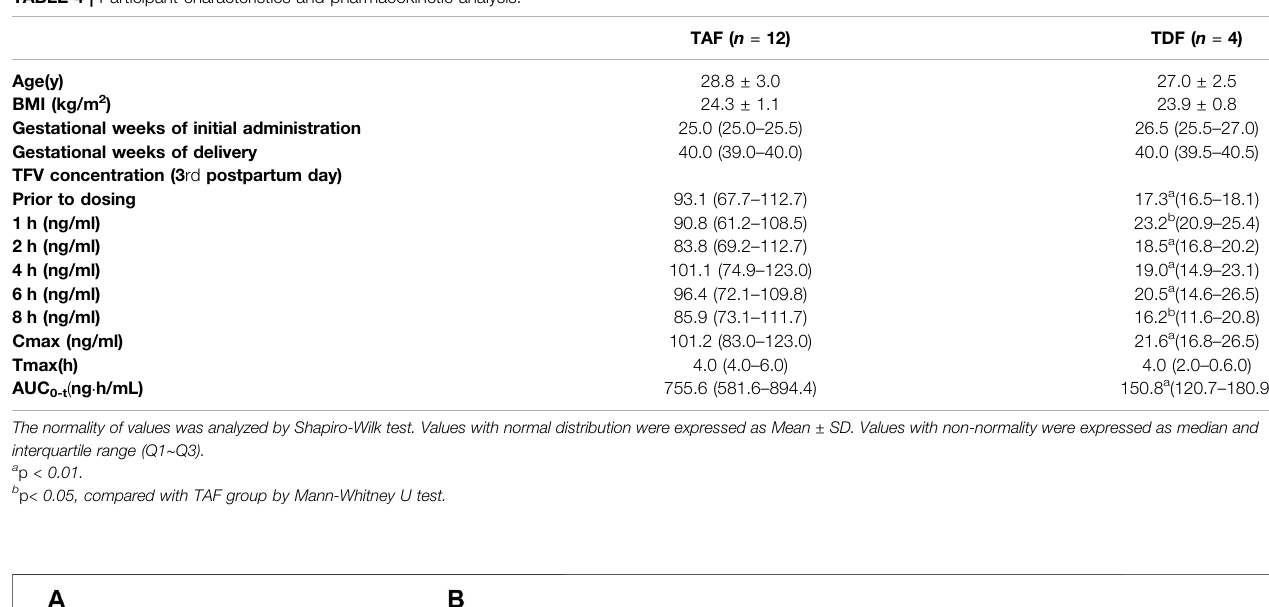
Frontiers in Pharmacology |